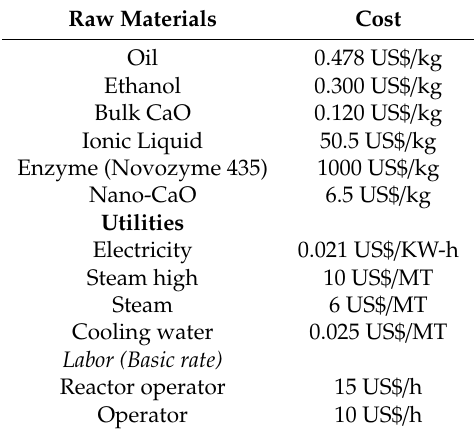
Table 2. The estimated cost of raw materials, labor, and utilities used in the four technology